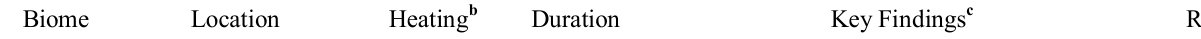
Table 2 . In situ field studies examining the effect of warming on soil microbial community a . Biome Key Findings c